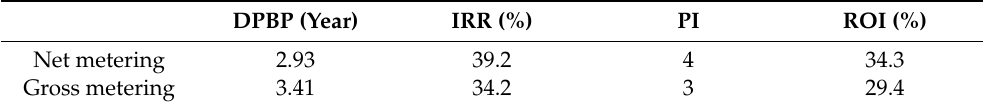
Table 12. Economic Determinants’ Results.